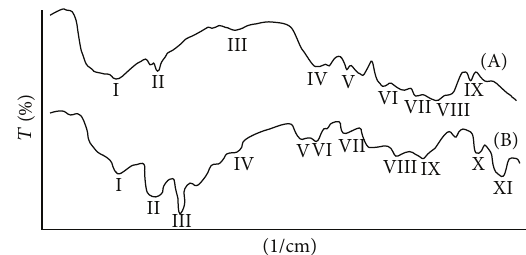
Figure1:FTIRofnatural P.karka andtreated P.karka (biosorbents).